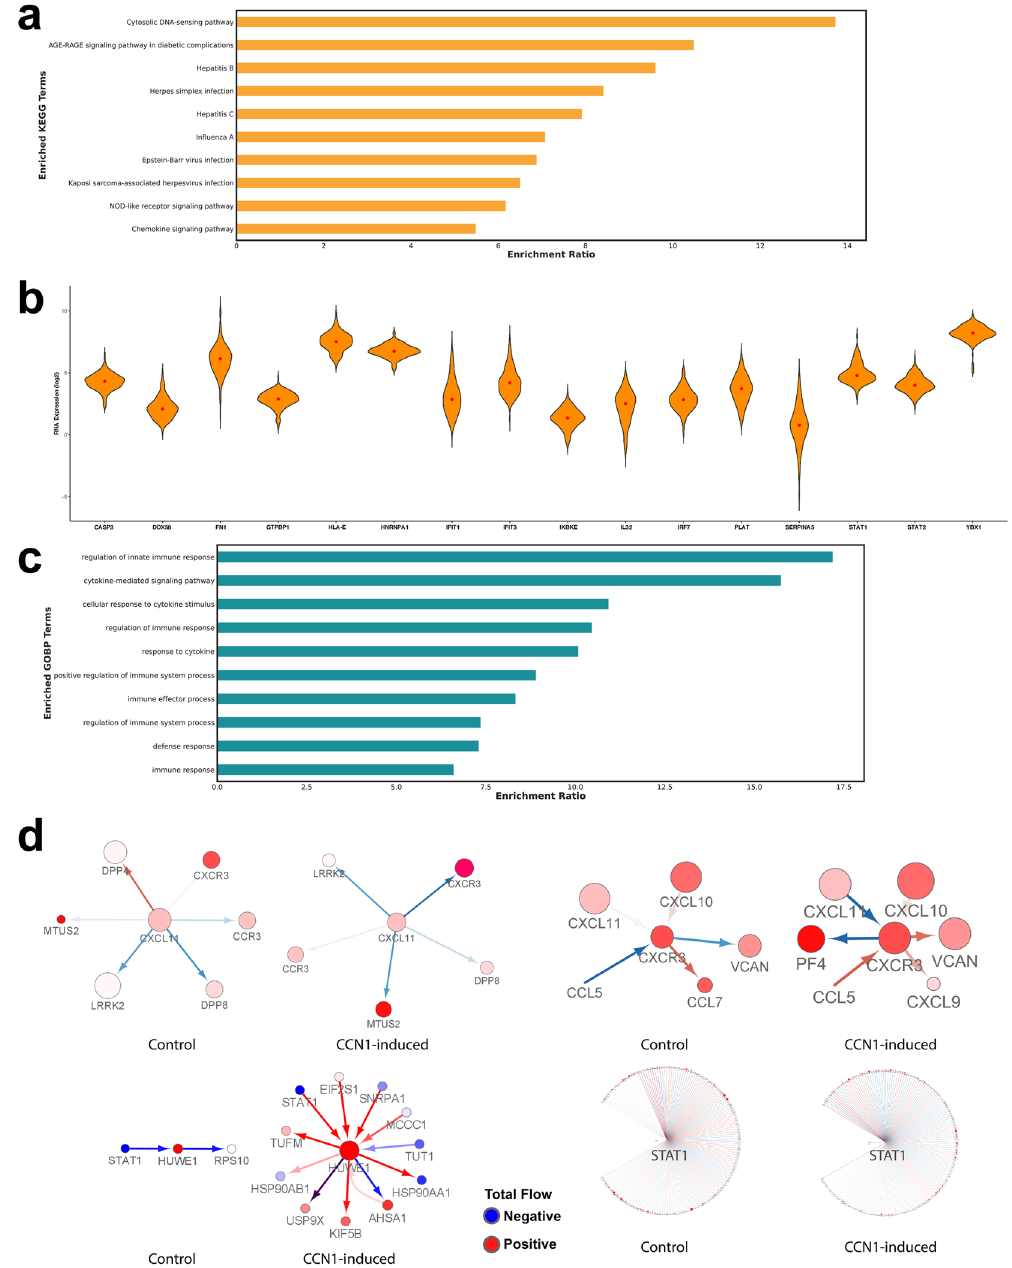
Figure 2. Glioblastoma enriched gene categories. ( a ) Overrepresentation enrichment KEGG analysis was performed using WebGestalt for the genes (n = 50) in CCN1 prioritized subnetwork. As expected, several genes used as flow sources in our network were reported within multiple enriched categories. ( b ) Violin plots showing the mRNA expression of HSV-1 (KEGG pathway: hsa05168) enriched genes in TCGA GBM patients (n = 174). ( c ) Overrepresentation enrichment GO Biological Process analysis was performed using WebGestalt for the genes (n = 21) involved in edges that dominate the network flow in CCN1-induced LN229 cells versus control (see Fig. 1d and Supplementary Fig. S1). We find that these edges comprise several cytokine signaling and immune response pathways. ( d ) CCN1-specific edge impact motifs for control and CCN1-induced. Rewiring is observed for CXCL11:CXCR3 and STAT1:HUWE1 pairs. Node degree and edge flows are drastically increased for HUWE1 in the context of CCN1